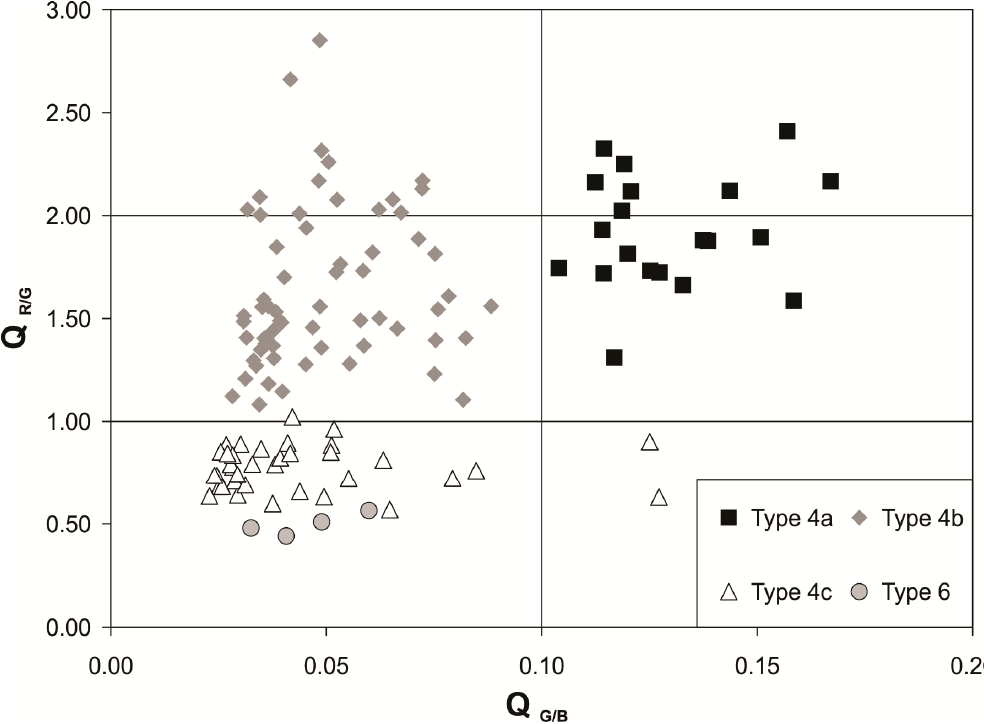
Figure 8. Bivariate plot of Q G/B vs. Q R/G for Type 4a, 4b and 4c inclusions. Table 4. Fluorescence data ( λ max , Q 650/500 and Q 510/430 ) and calculated API gravity from Type 4 and Type 6 inclusions. Refer to Table 1 for sample depths and formations.